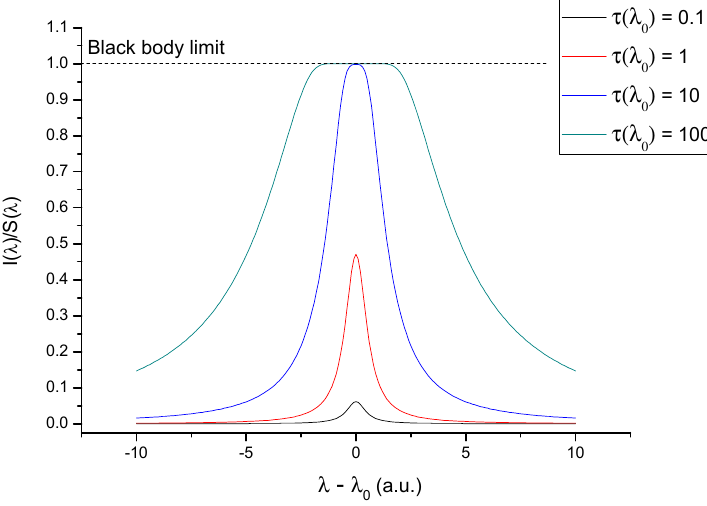
Figure 1. E ff ect of self-absorption on the line shape (numeric Figure 1. Effect of self-absorption on the line shape (numeric calculation).